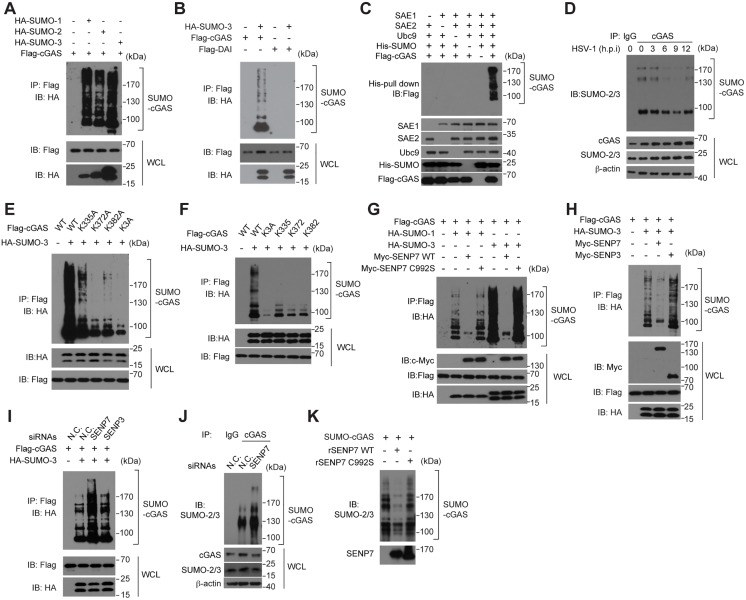
SENP7 modulates the dynamic equilibrium of cGAS SUMOylation.(A) Flag-tagged cGAS were transfected into HEK293T cells along with HA-tagged SUMO-1 or HA-tagged SUMO-2/3. 36 hr after transfection, cell lysates were immunoprecipitated with an anti-Flag antibody. The immunoprecipitates were denatured and reimmunoprecipitated with an anti-Flag antibody, and then analyzed by immunoblotting with the indicated antibodies. (B) HEK293T cells were transfected with the indicated plasmids. 36 hr after transfection, cell lysates were subjected to a two-step immunoprecipitation and then immunoblotted with the indicated antibodies. (C) The SUMOylation reaction mixture contains E1, E2, SUMO and cGAS as indicated. After incubation for 120 min, the mixture was detected by immunoblotting with Flag antibody. (D) BMDMs were infected or not with HSV-1 for the indicated time periods, and the lysates were subjected to denaturing immunoprecipitation with an anti-cGAS antibody or normal IgG, and then analyzed by immunoblotting with the indicated antibodies. (E, F) Flag-tagged mouse cGAS or its mutants were individually transfected into HEK293T cells along with HA-tagged SUMO-2/3. Cell lysates were subjected to a two-step immunoprecipitation, and then immunoblotted with the indicated antibodies. K3A denotes cGAS with lysine residues 335/ 372/ 382 mutated to alanine. (G, H) HEK293T cells were transfected with the indicated plasmids. 36 hr post-transfection, cell lysates were subjected to a two-step immunoprecipitation and then immunoblotted with the indicated antibodies. (I) HEK293T cells were transfected with the indicated siRNAs. 36 hr later, Flag-cGAS and HA-SUMO-3 were transfected into the knockdown cells. Cell lysates were subjected to a two-step immunoprecipitation with Flag antibody and immunoblotted with the indicated antibodies. (J) MEFs were transfected with the indicated siRNAs and the cell lysates were subjected to denaturing immunoprecipitation with an anti-cGAS antibody or normal IgG, and then analyzed by immunoblotting with the indicated antibodies. (K) The deSUMOylation reaction mixture contains SUMOylated cGAS and recombinant WT or catalytically-dead SENP7 as indicated. After incubation for 30 min, the mixture was detected by immunoblotting with the indicated antibodies. All data shown are representative of three independent experiments.